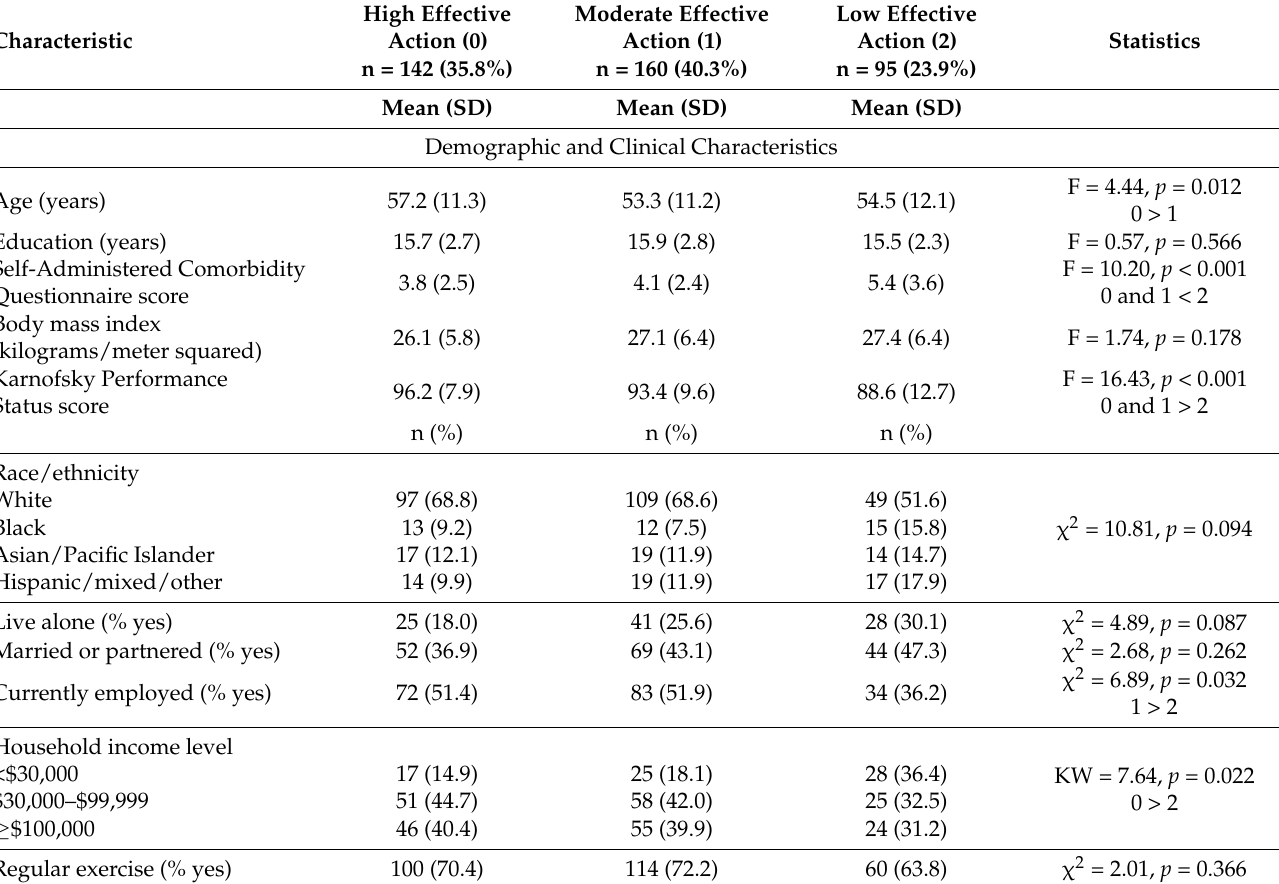
Table 4. Differences in Demographic, Clinical, and Symptom Characteristics among the Effective Action